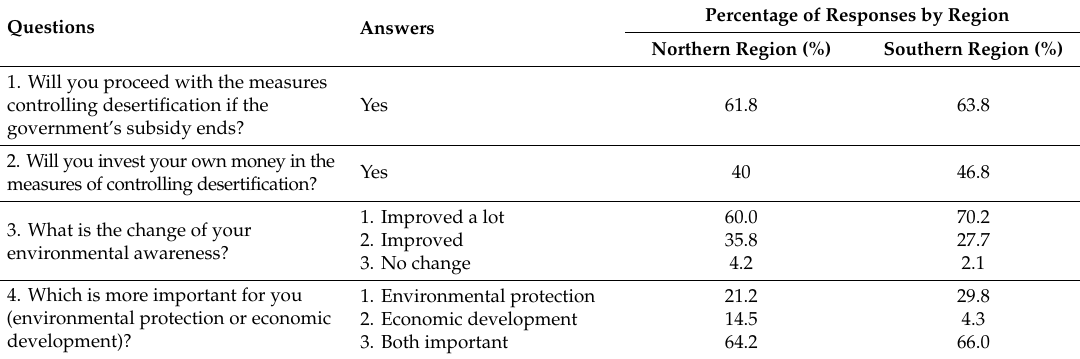
Table 4. Farmers’ environmental awareness after the